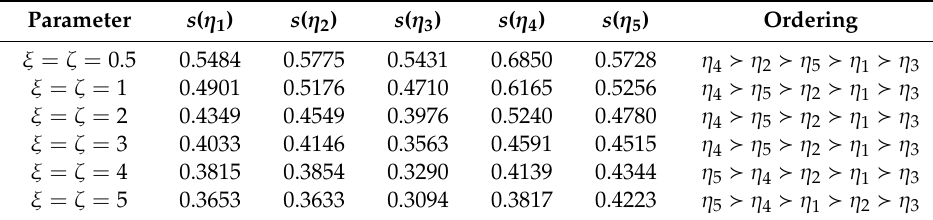
Table 3. Ordering by the DHPFGGWHM